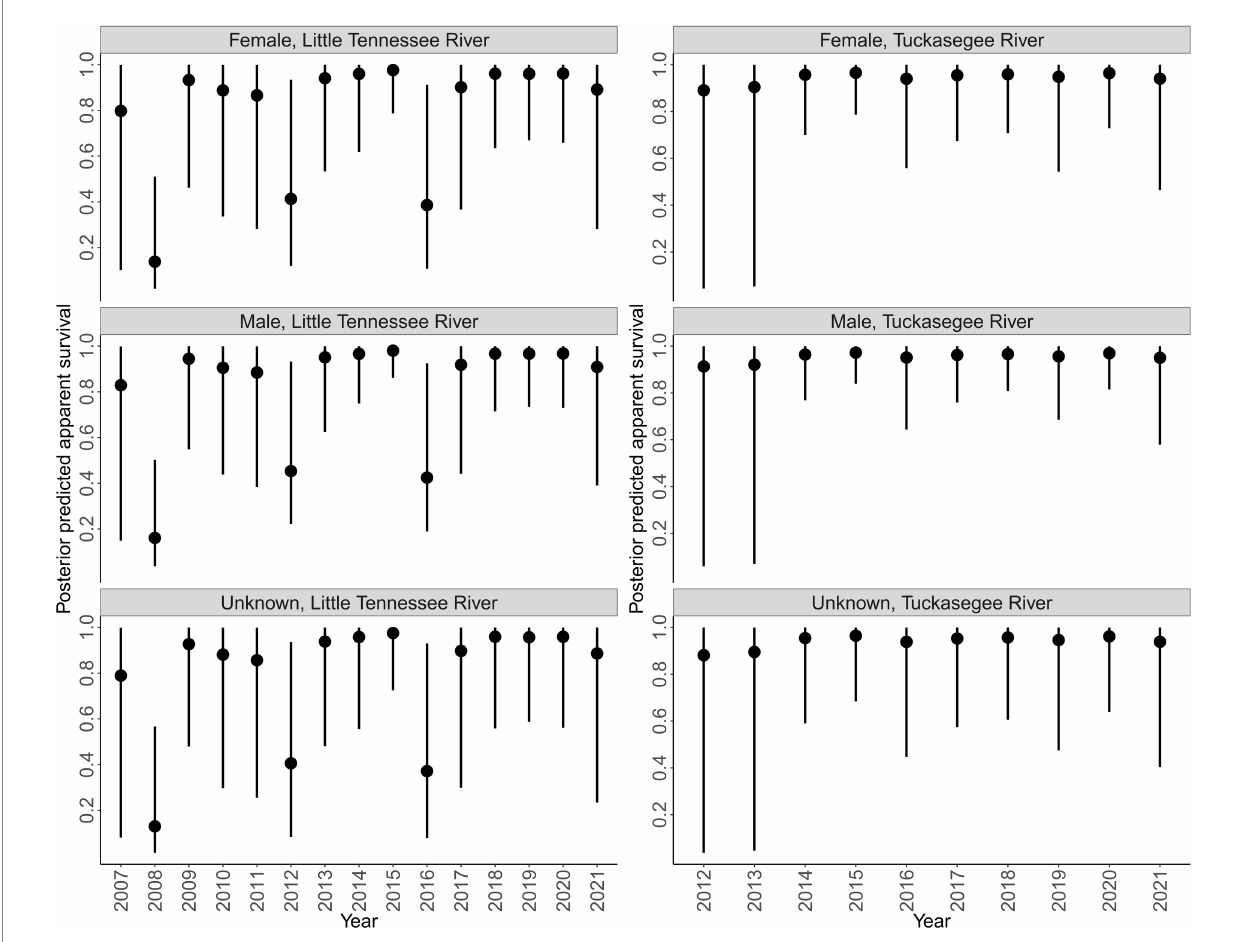
FIGURE 4 Posterior predicted annual survival of Sicklefin Redhorse Moxostoma sp. in the Little Tennessee River (left) and Tuckasegee River (right) for females, males, and unknown sex. Solid points represent the median and vertical black lines represent the bounds of the 95% credible intervals.